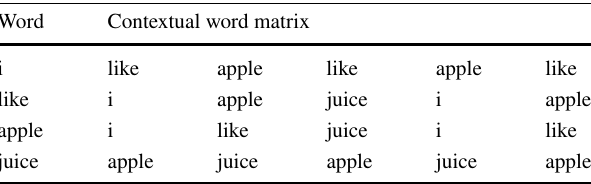
Table 4. Element m i , j ∈ M represents the j th contextual words of the i th word in the vocabulary.